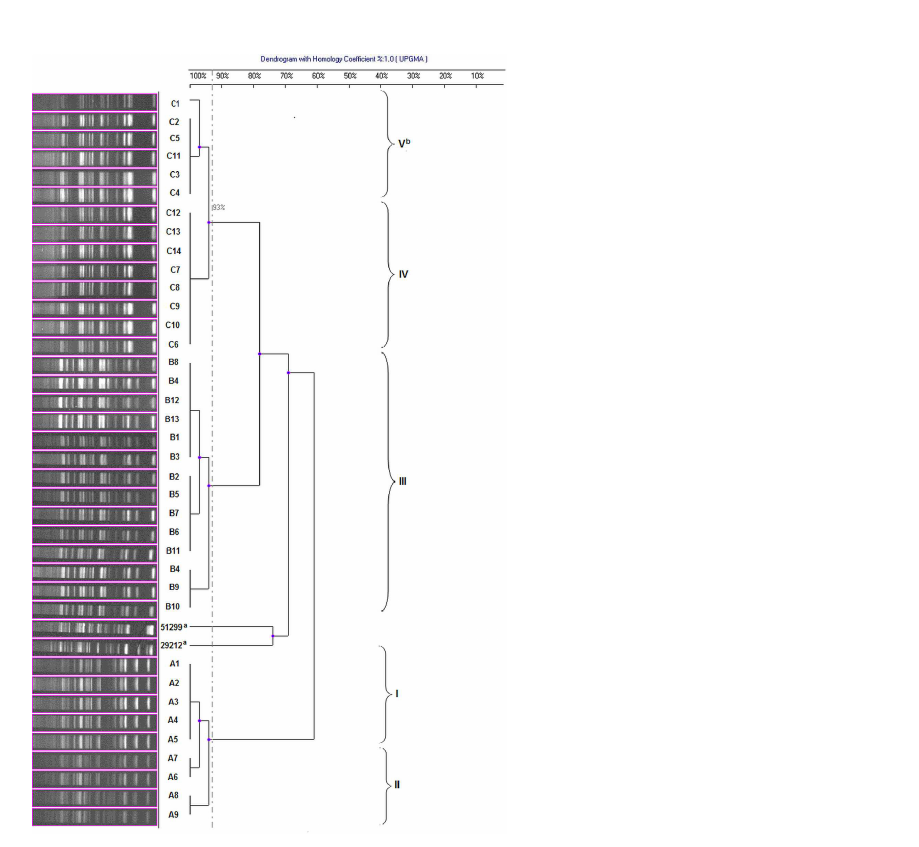
Fig 1. Dendrogram of genetic relatedness among E . faecalis strains obtained with the ADSRRS- fingerprinting method. a reference strains of E . faecalis :ATCC29212 and ATCC51299 b resistancegene